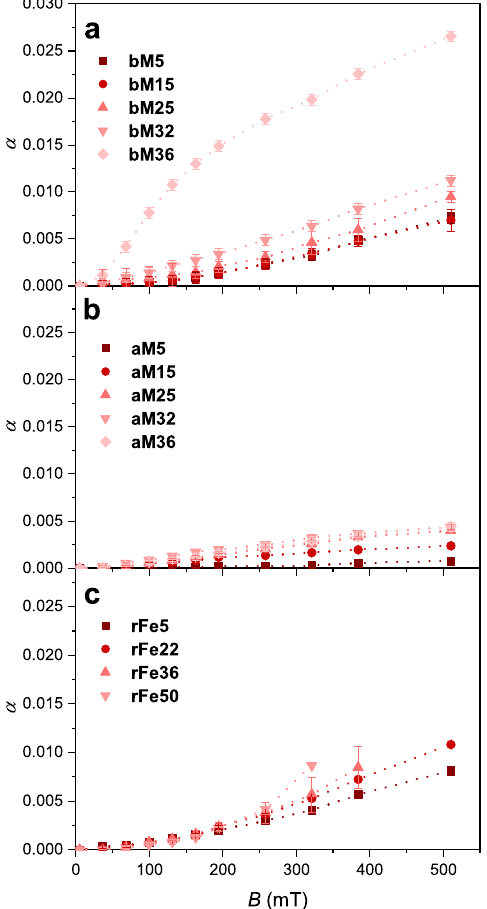
Figure 7. Deformation of samples as a function of the magnetic flux density at different concentrations of bM magnetite ( a ), aM magnetite ( b ), and rFe iron ( c ) filler. The dotted lines are a guide for the eye. In some cases, the error bar is smaller than the